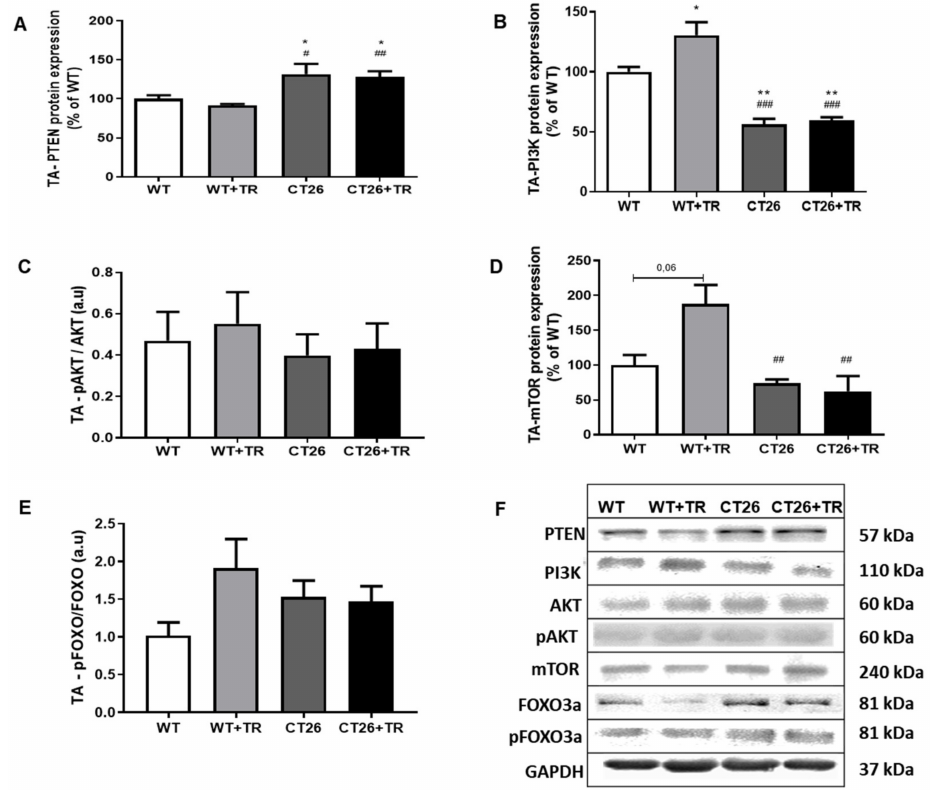
Figure 9. CT26 cachectic mice: PTEN/PI3K/AKT/mTOR pathway proteins expression in tibialis anterior (TA) using Western blot. ( A ) PTEN protein expression. ( B ) PI3K protein expression. ( C ) pAKT and AKT protein expression ratio. ( D ) mTOR protein expression. ( E ) pFOXO3a and FOXO3a protein expression ratio. ( F ) Proteins: PTEN, PI3K, AKT, pAKT, mTOR, FOXO3a, pFOXO3a and GAPDH representative blots. Groups: WT—wild type sedentary ( n = 8); WT+TR—wild type trained ( n = 5); CT26—colon cancer sedentary ( n = 9); CT26+TR—colon cancer trained ( n = 7). Data are reported as means ± SEM. * p < 0.05 vs. WT, ** p < 0.01 vs. WT, # p < 0.05 vs. WT+TR, ## p < 0.01 vs. WT+TR and ### p < 0.001 vs.